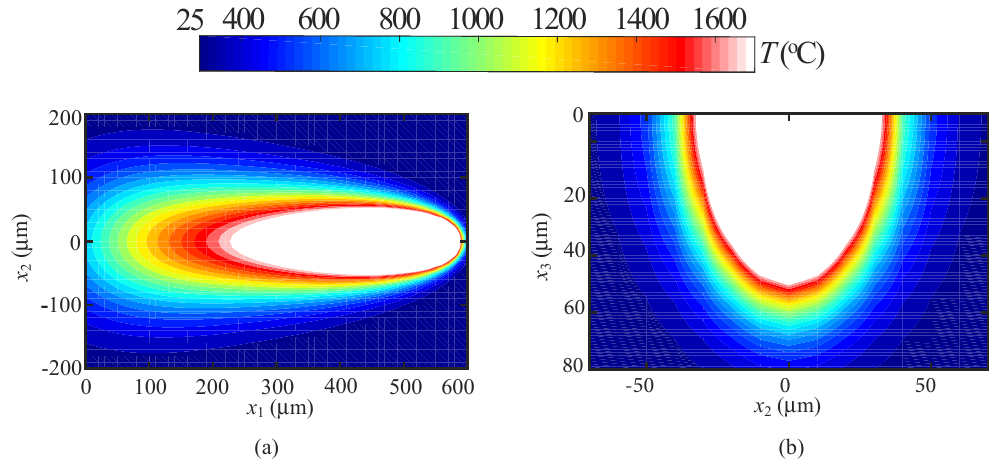
Figure 5. The temperature profile within the ( a ) x 1 − x 2 plane and ( b ) x 2 − x 3 plane for the power of 150 W and the speed of 0.8 m/s. The melt-pool is shown as the white